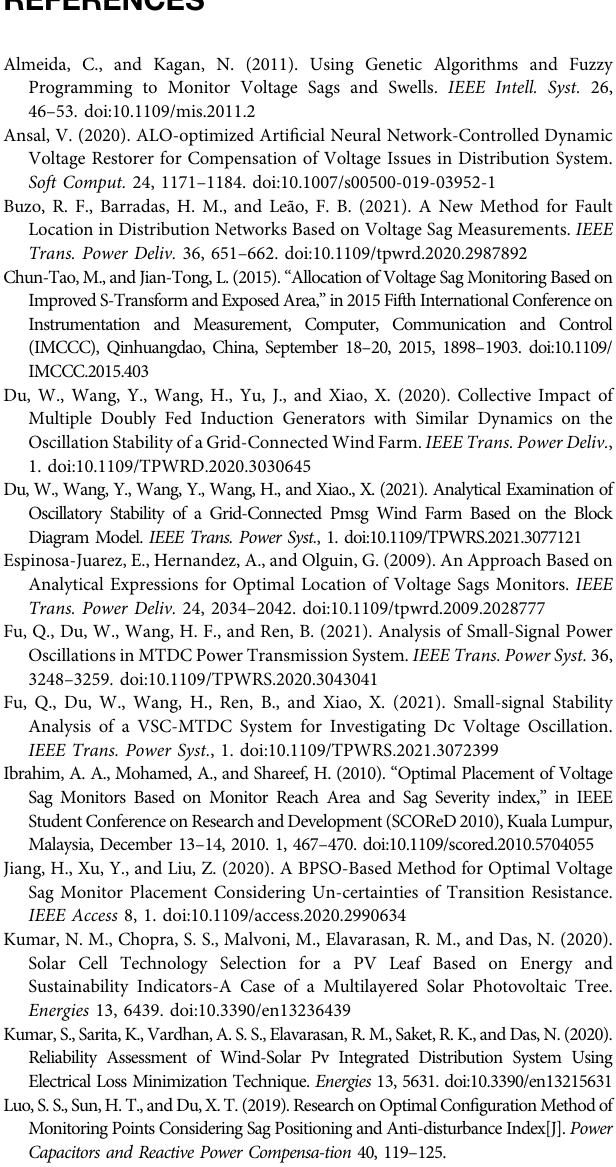
Algorithm. Energies 14, 255. doi:10.3390/en14010255 Sun, R., Ma, J., and Yang, W. (2021). Transient Synchronization Stability Control